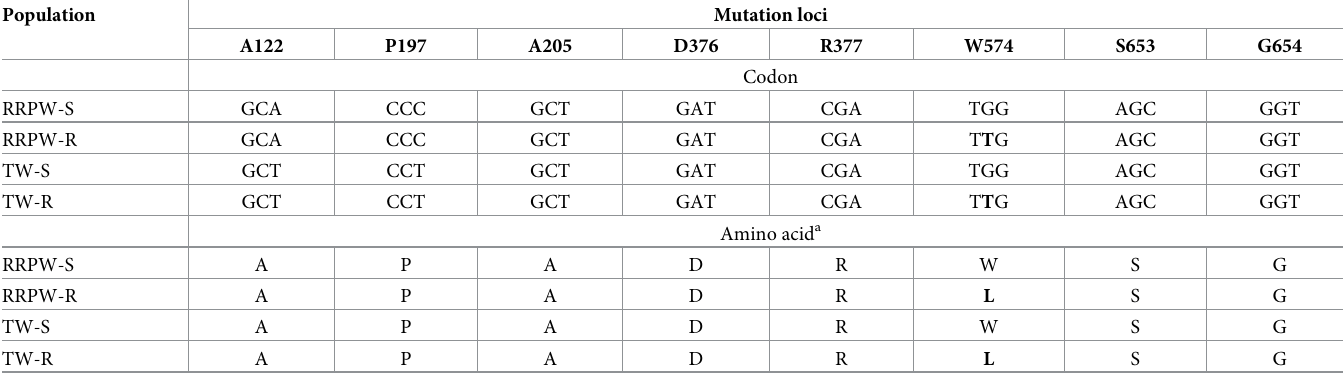
Table 1. DNA codons and corresponding amino acids at eight loci on the ALS gene, known to have point mutations leading to an altered ALS enzyme, in popula- tions of Amaranthus retroflexus (RRPW-R and RRPW-S) and A . tuberculatus (TW-R and TW-S) that are resistant and susceptible to selected ALS-inhibiting